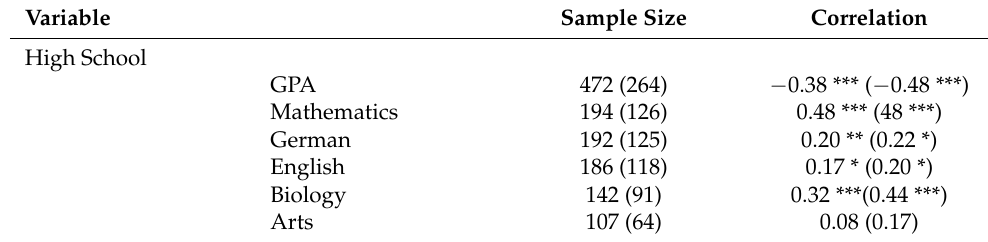
Table 6. Correlations between HeiQ scores and academic achievement